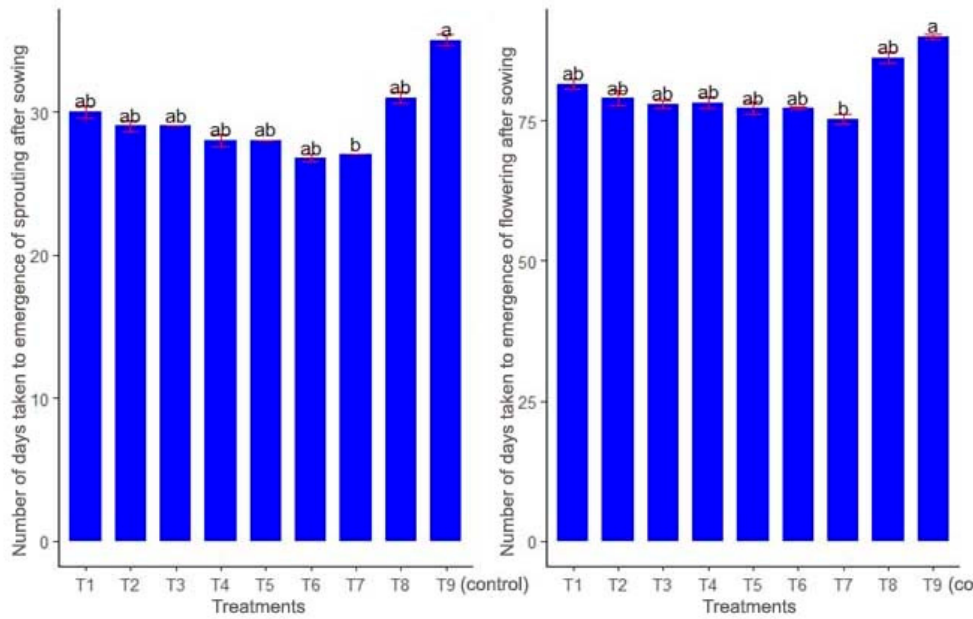
Figure 3. E ff ect of di ff erent treatments on the sprouting and flowering of sa ff ron. Bars represent mean Figure 3. Effect of different treatments on the sprouting and flowering of saffron. Bars represent mean ( ± standard error) of sprouting and flowering of sa ff ron in T 1 = Bacillus stratosphericus at 1 × 10 9 cfu / mL; (± standard error) of sprouting and flowering of saffron in T 1 = Bacillus stratosphericus at 1 × 10 9 cfu/mL; T 2 = B. pumilus at 1 × 10 9 cfu / mL; T 3 = B. subtilis at 1 × 10 9 cfu / mL; T 4 = Pseudomonas aeruginosa at T 2 = B. pumilus at 1 × 10 9 cfu/mL; T 3 = B. subtilis at 1 × 10 9 cfu/mL; T 4 = Pseudomonas aeruginosa at 1 × 10 9 1 × 10 9 cfu / mL; T 5 = P. putida at 1 × 10 9 cfu / mL; T 6 = P. fluorescens at 1 × 10 9 cfu / mL; T 7 = Trichoderma cfu/mL; T 5 = P. putida at 1 × 10 9 cfu/mL; T 6 = P. fluorescens at 1 × 10 9 cfu/mL; T 7 = Trichoderma asperellum asperellum at 1 × 10 8 cfu / mL; T 8 = carbendazim 50 WP at 0.2%; and T 9 = water (control). Means followed at 1 × 10 8 cfu/mL; T 8 = carbendazim 50 WP at 0.2%; and T 9 = water (control). * Means followed by the by the same letter do not significantly di ff er ( p < 0.05) with same letter do not significantly differ ( p < 0.05 ) with DNMRT.